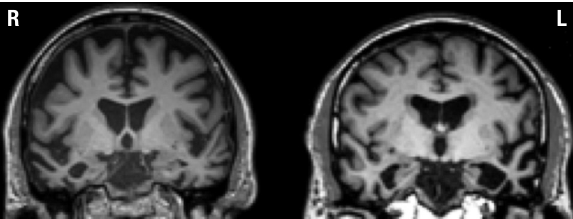
Figure 1. Structural T1-weighted coronal images of the representative pat- terns of atrophy in semantic dementia patients with predominantly right (R) or left (L) temporal lobe